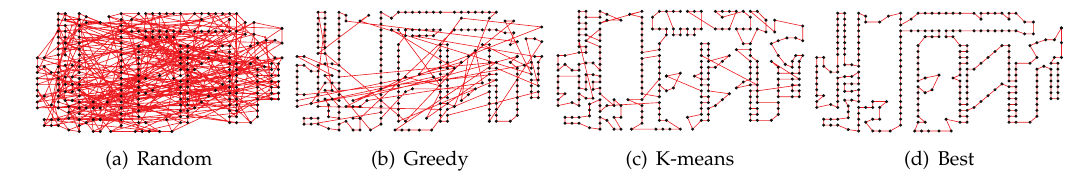
Figure2:Threemethodstoinitializethepopulationofproblema280[35].(a)isRIG,(b)isgeneratedbyagreedymethod(GIP)[25],(c)is KIP,and(d)isthebestsolutionofthisproblem.